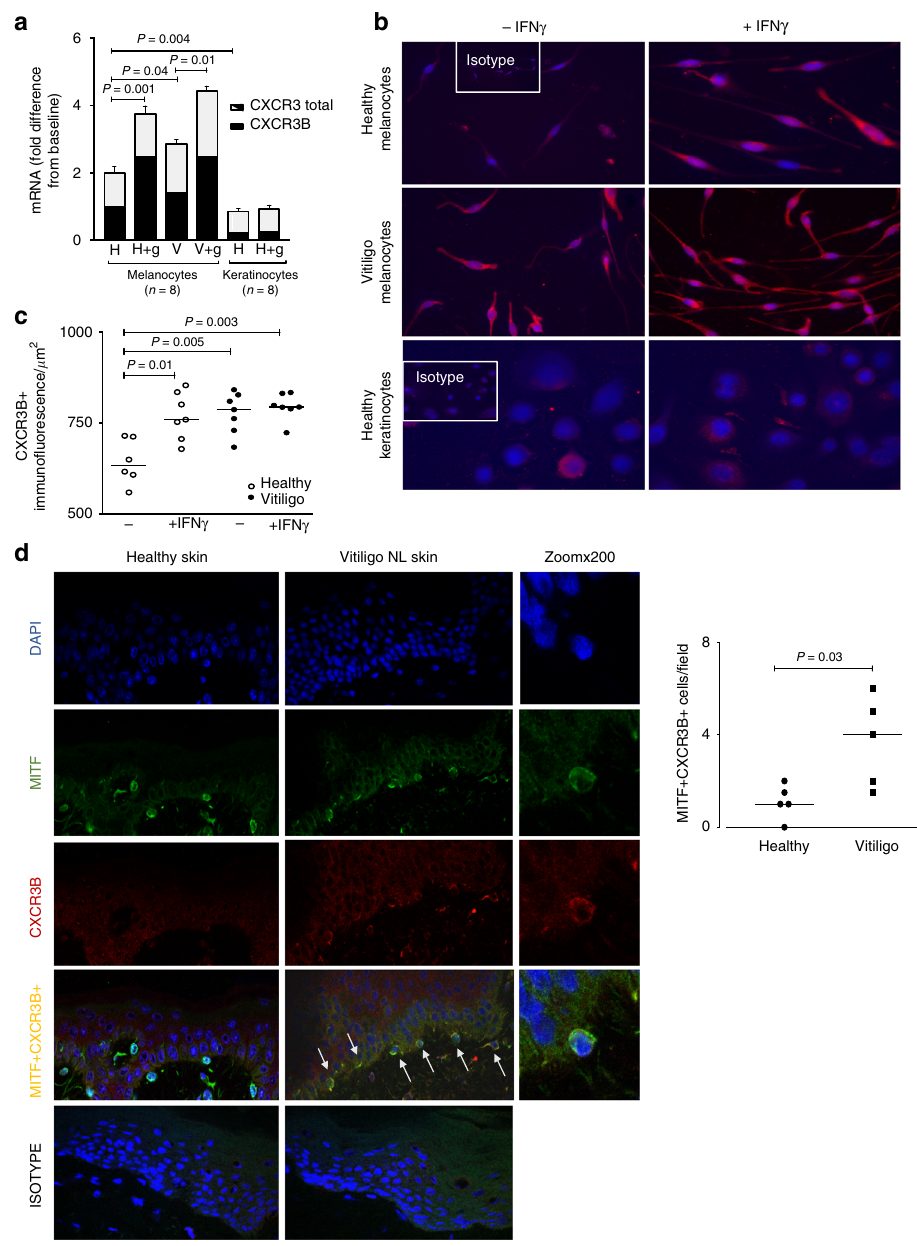
Fig. 3 Expression of CXCR3B in human melanocytes and their regulation by IFN γ . a Total CXCR3 mRNA (black + white bars) and CXCR3B mRNA (black bars) in healthy and vitiligo primary melanocytes ( n = 8) and healthy keratinocytes ( n = 5) before and after exposure to IFN γ 50 ng/ml for 24 h. Results are normalized to unstimulated melanocytes from healthy subjects and expressed as mean ± SEM. b Immuno-detection of CXCR3B protein and c its semi- quanti fi cation in melanocytes extracted from healthy skin (open circles, n = 6 – 7) and skin from vitiligo patients (closed circles, n = 7) before and after IFN γ stimulation. d In situ detection of CXCR3B + melanocytes (MITF + CXCR3B + ) in vitiligo non-lesional (NL) skin and their quanti fi cation ( n = 5) compared to healthy skin ( n = 5). Results are shown as individual dot plots with a line at visualised in Fig. 4b by reduction in yellow-stained dead cells). To more speci fi cally examine the contributing role of CXCR3B, we repeated this experiment in both healthy and vitiligo melanocytes using custom design speci fi c silencer RNA directed against the CXCR3B isoform (ef fi ciency of the SiCXCR3B at protein level shown in Supplementary Fig. 4c). Transfection of melanocytes with siCXCR3B prior to CXCL10 stimulation, signi fi cantly reduced the CXCL10-induced death in both healthy ( P = 0.002) and vitiligo ( P = 0.001) melanocytes (Fig. 4d). In addition to CXCL10, we examined responses to CXCL9 and CXCL11.